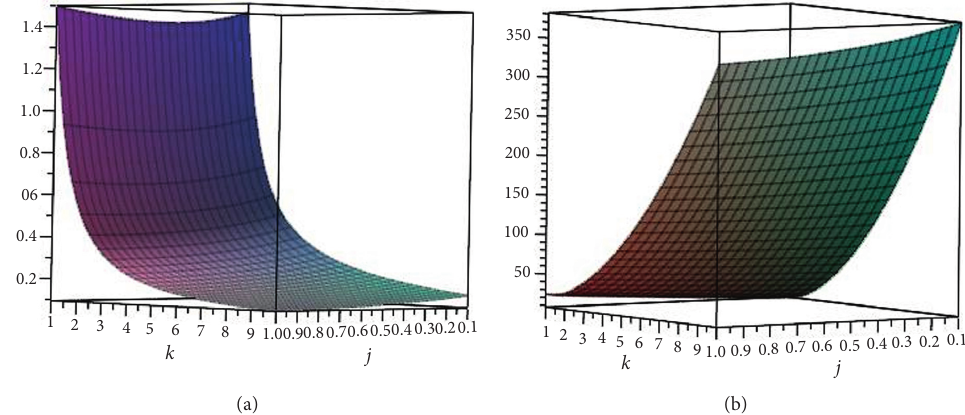
Figure 5: (a) Inverse Randic index for j ≥ k and α � 1. (b) Symmetric division index for j ≥ k and α � 1.